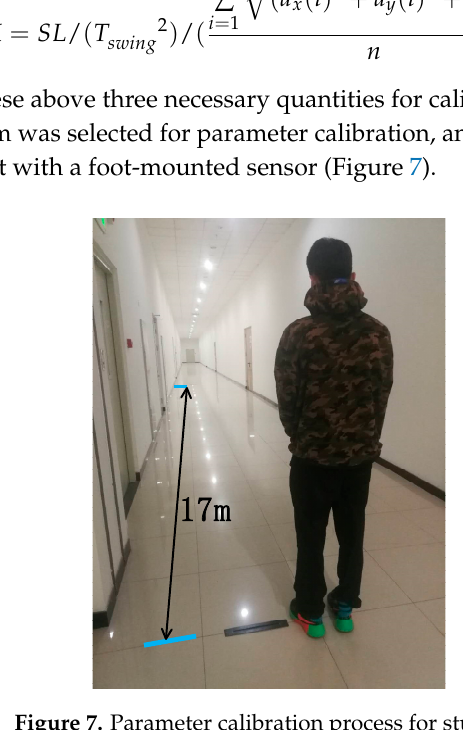
Figure 7. Parameter calibration process for student.